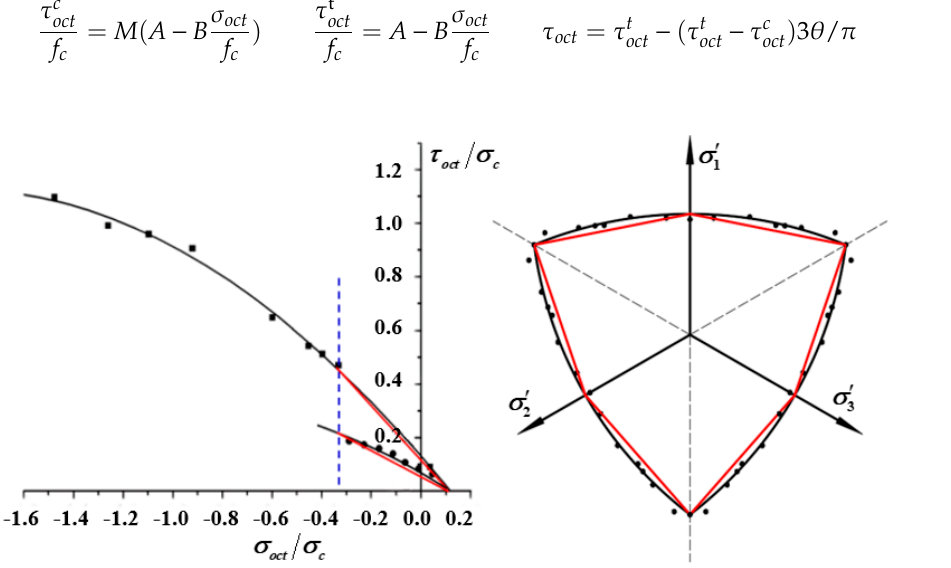
Figure 5. The nonlinear and linear strength models of asphalt mixture.